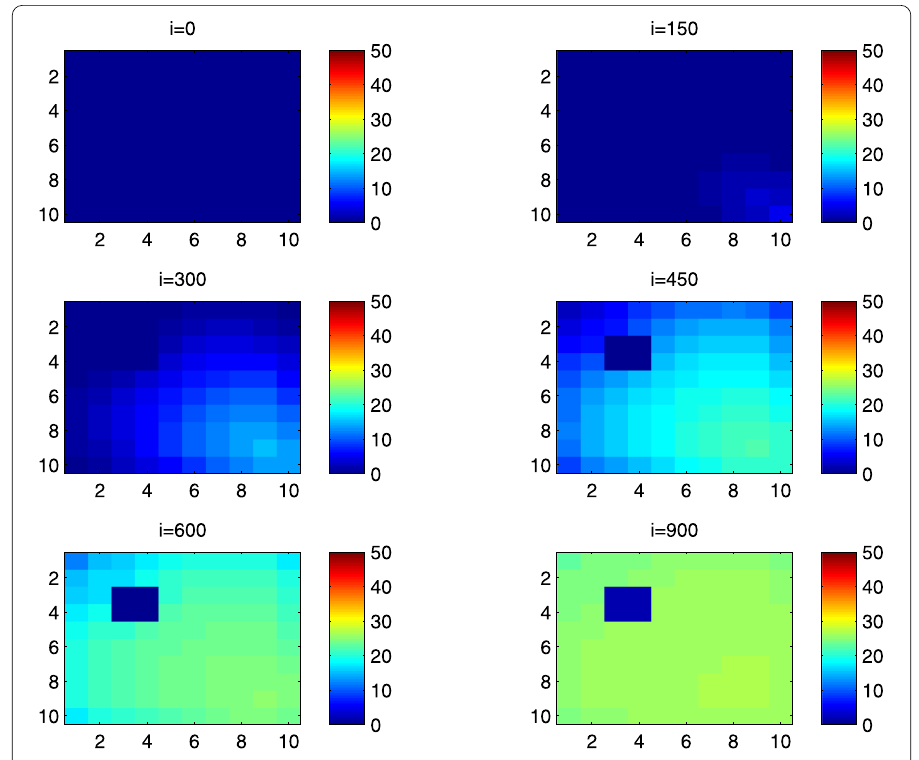
Figure 12 R Cpq behavior in the presence of optimal controls (11). The case when the disease starts from the corner C 11